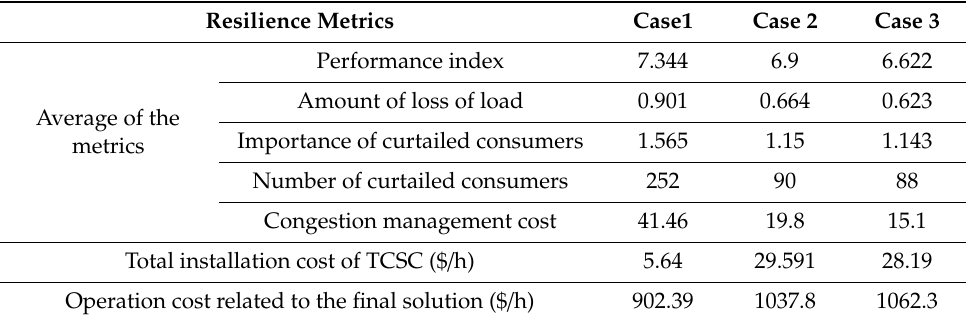
Table 5. Average of the Resilience Metrics and Operation Cost.